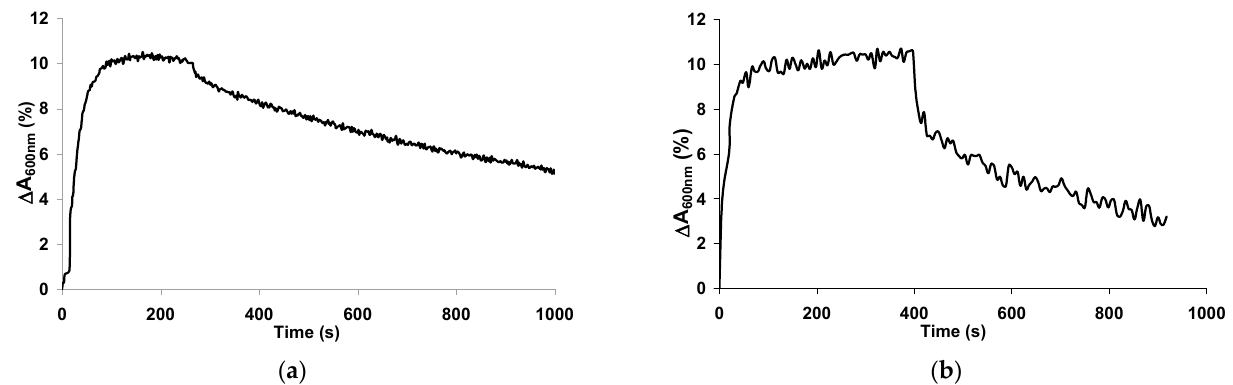
Figure 8. The response of PANI-PAMPSA film exposed to 52 ppm of ammonia and its regeneration in air ( a ) and via resistive heating of the FTO layer ( b ).